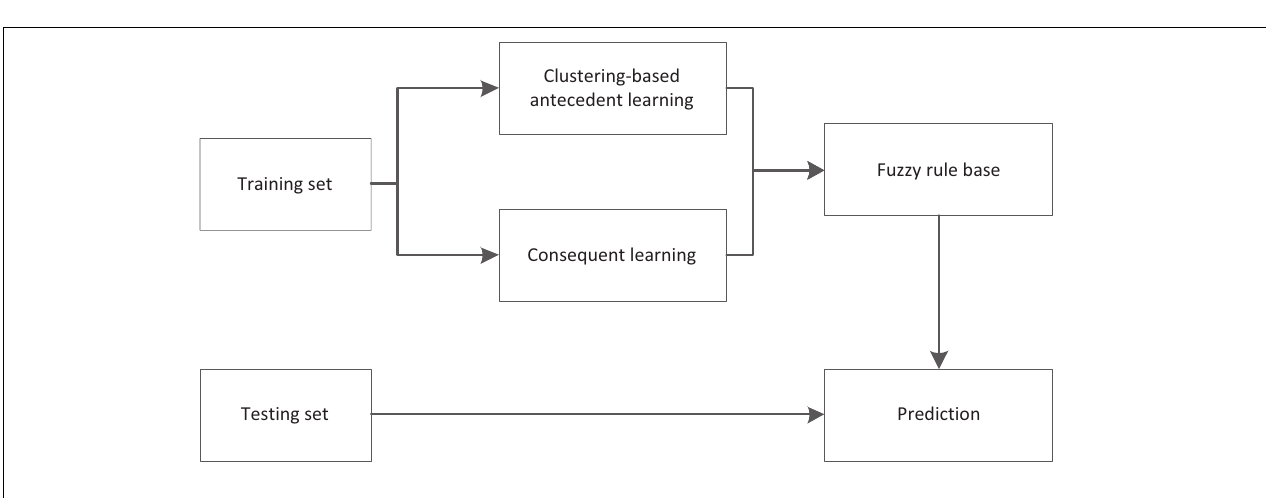
FIGURE 2 | Learning framework of Takagi–Sugeno–Kang (TSK) fuzzy